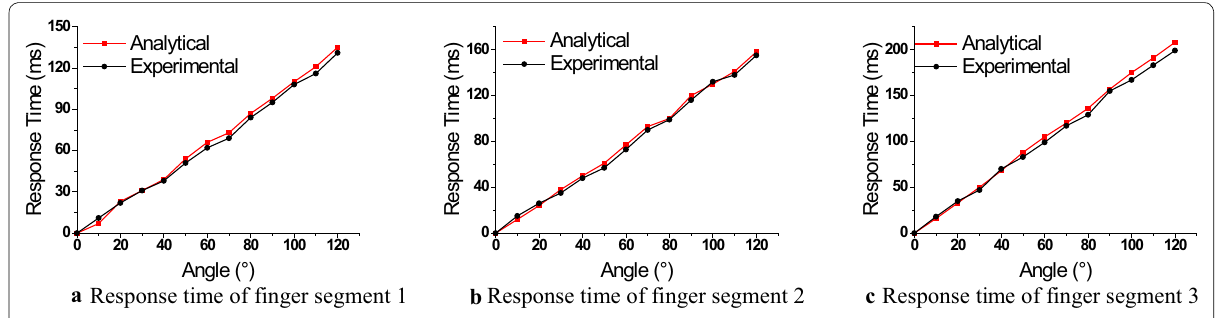
Figure 12 Response time of each finger segment